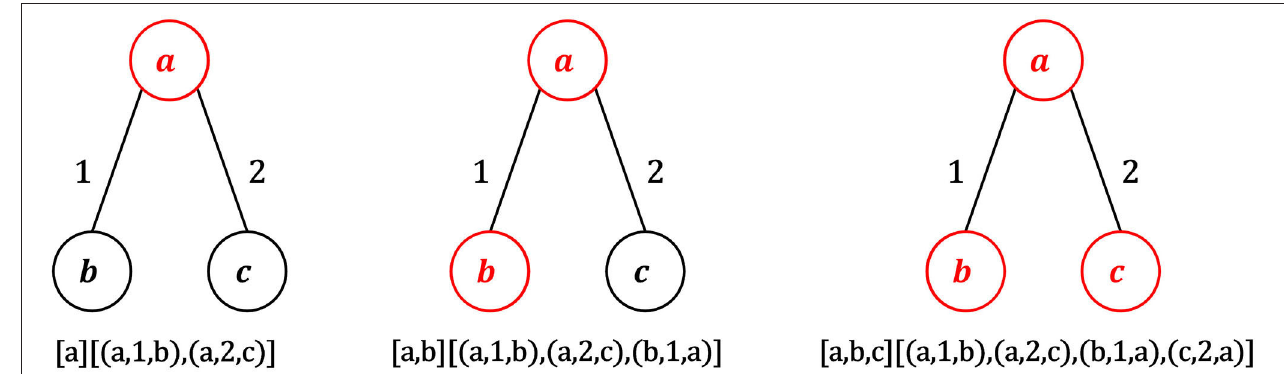
FIGURE 3 | Example of construction of the canonical form. Node a has the highest degree (2), so a is the first node of the ordering. Nodes b and c have the same degree, so we need to examine the adjacency lists of b and c sorted by timestamp and destination node. The first edge in the sorted list of b has timestamp 1, while the first edge in the sorted list of c has timestamp 2, so the second node of the ordering is b and the third one is c . Following such node ordering, the canonical form of the graph in the figure is { ( a ,1, b ),( a ,2, c ),( b ,1, a ),( c ,2, a ) }